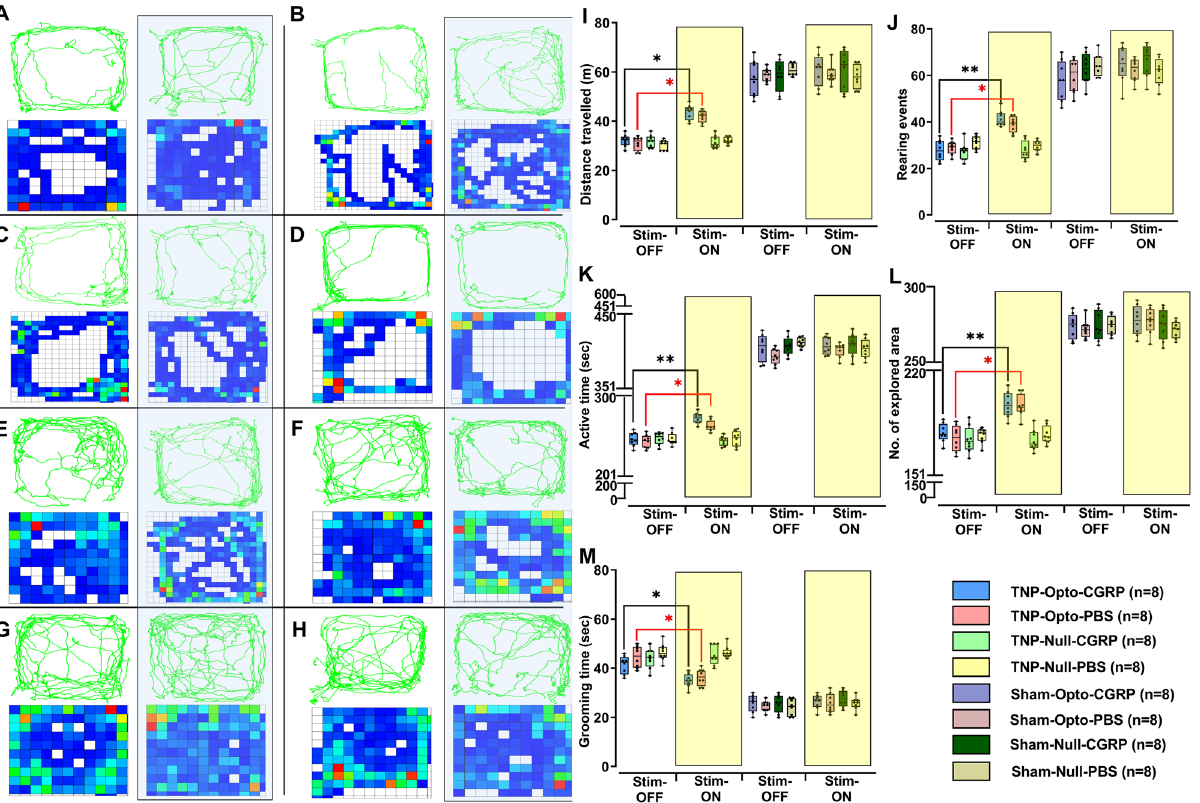
Figure 6. Alteration of behavioral responses in the open field test upon optogenetic inhibition. ( A – H ) Trajectory and exploration representations of the TNP-Opto-shCGRP (n = 8) ( A ), TNP-Opto-PBS (n = 8) ( B ), TNP-Null-shCGRP (n = 8) ( C ), TNP-Null-PBS (n = 8) ( D ), Sham-Opto-shCGRP (n = 8) ( E ), Sham-Opto-PBS (n = 8) ( F ), Sham-Null-shCGRP (n = 8) ( G ), and Sham-Null-PBS (n = 8) ( H ) groups during stimulation “OFF” and “ON” conditions. ( I ) Distance traveled, ( J ) number of rearing events, ( K ) duration of active time, ( L ) number of explored areas, and ( M ) duration of grooming time. In all the behavioral paradigms, the TNP- Opto-shCGRP (n = 8) and TNP-Opto-PBS (n = 8) groups exhibited significant alterations in the stimulation “ON” condition but no significant changes in behavioral scores were observed in other animal groups in the stimulation “ON” condition. *, p < 0.05; **, p < 0.01, significant differences determined using paired t -test. Data are displayed as means ±